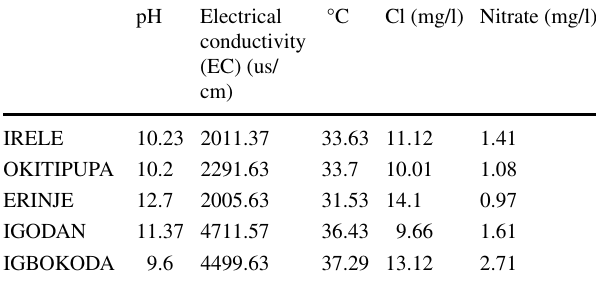
Table 1 Descriptive statistics of physicochemical parameters in the different